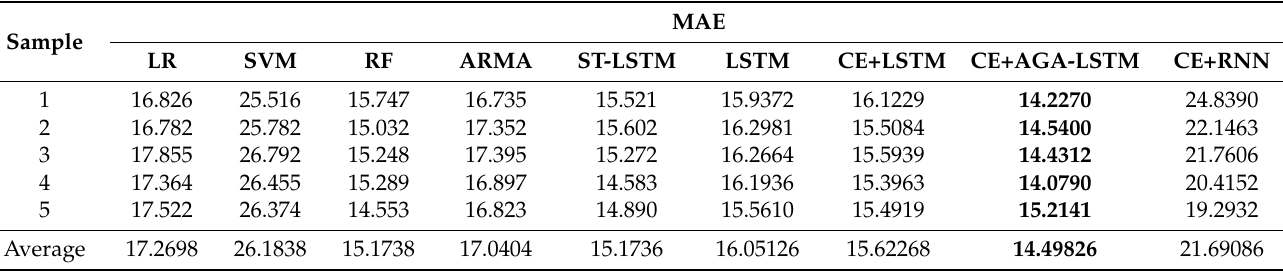
Table 5. Mean Values of MAE in five